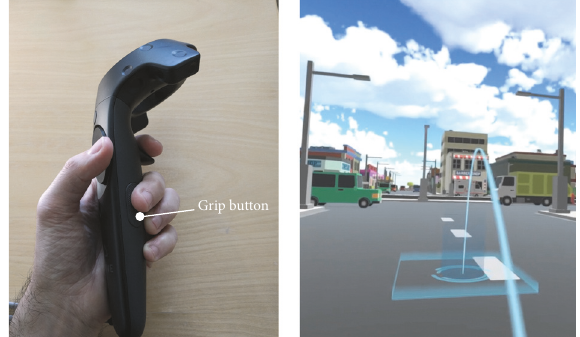
Figure 4: Interacting with the HTC Vive controller for the tele- portation technique ( left ) and a view of the virtual environment ( right ). Video demonstration of virtual navigation: http://boletsis